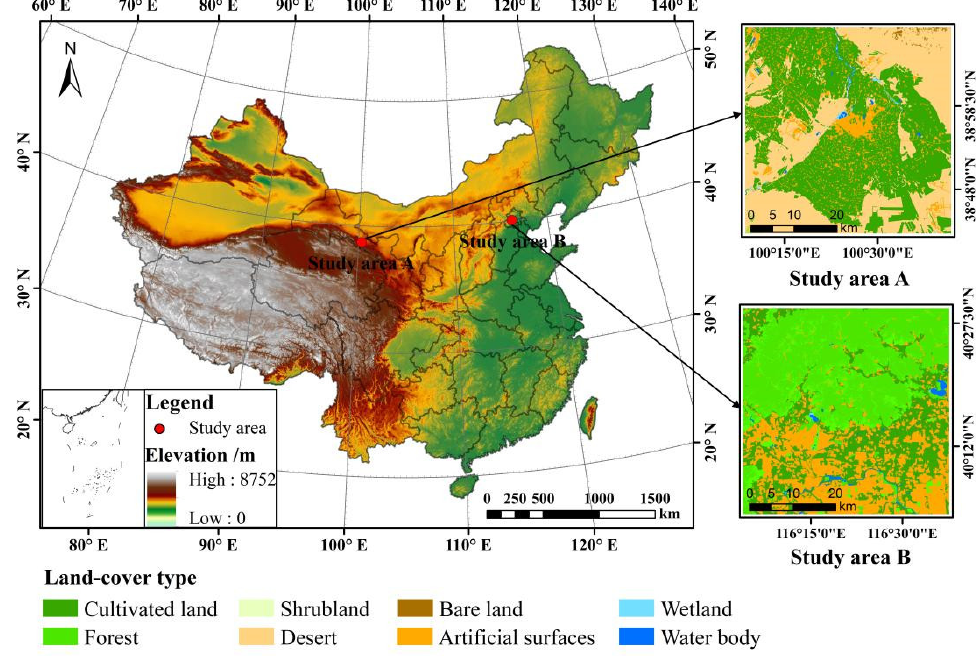
Figure 1. Geographical locations and land-cover maps of study areas (The land cover maps in two study areas are acquired from the 30-m resolution global land cover dataset).